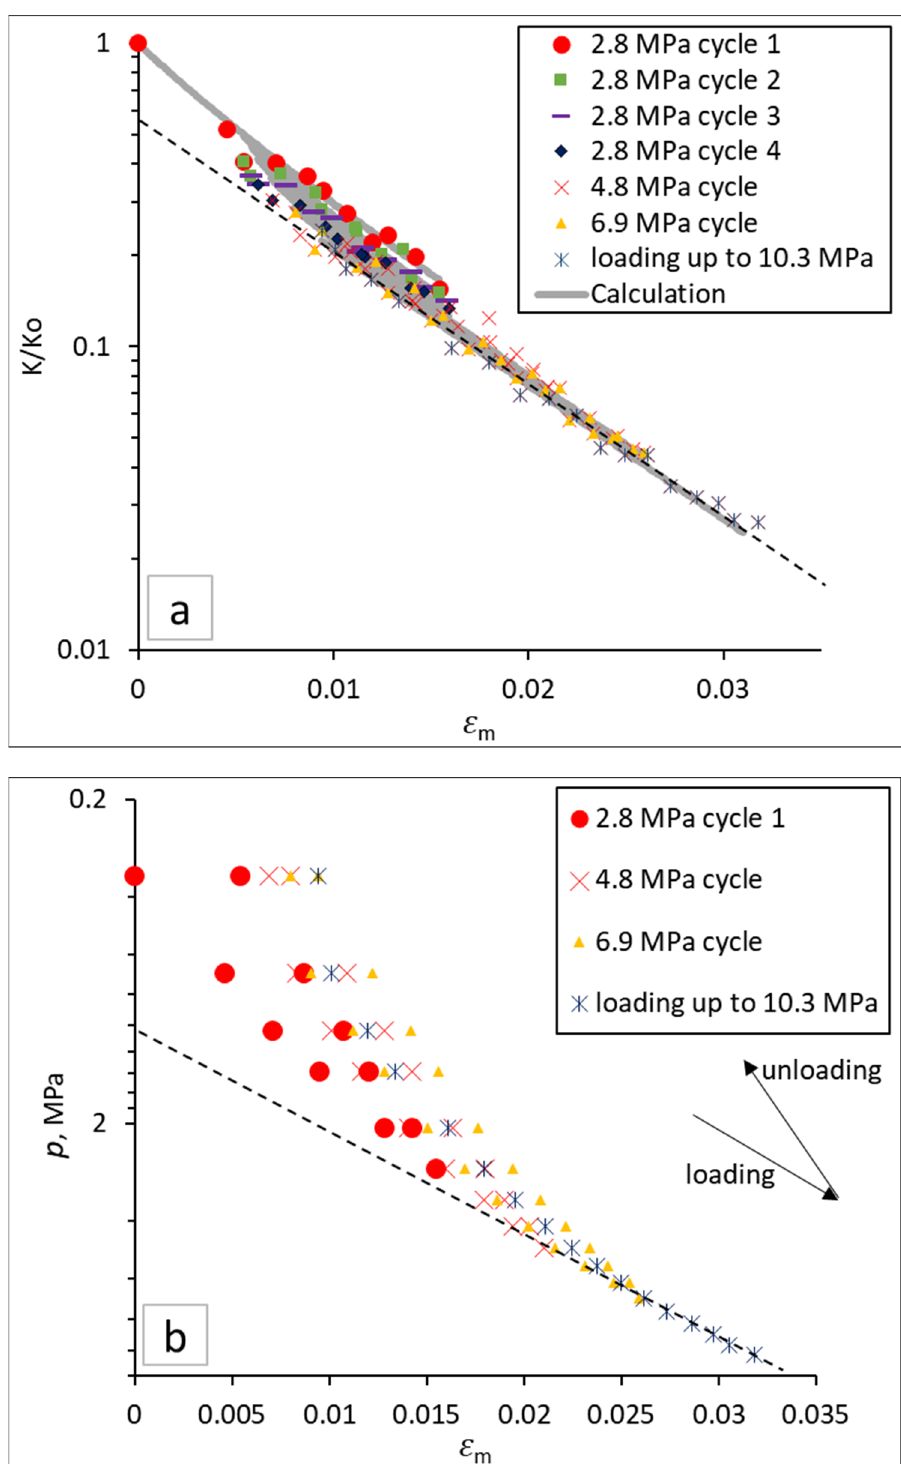
Figure 24. Permeability and strain of coal sample 4 (test 4).